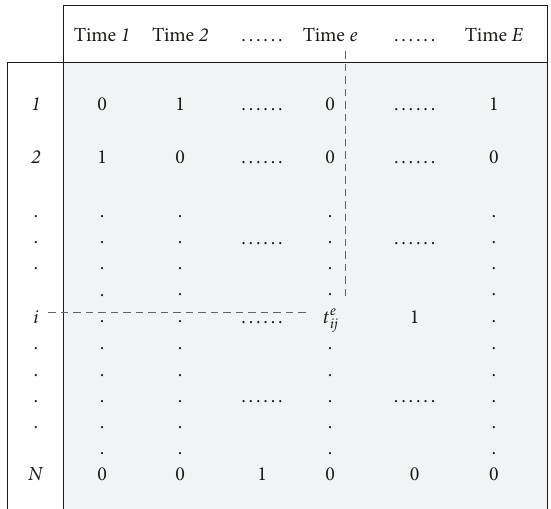
Figure 4: Schematic of decision variable t e